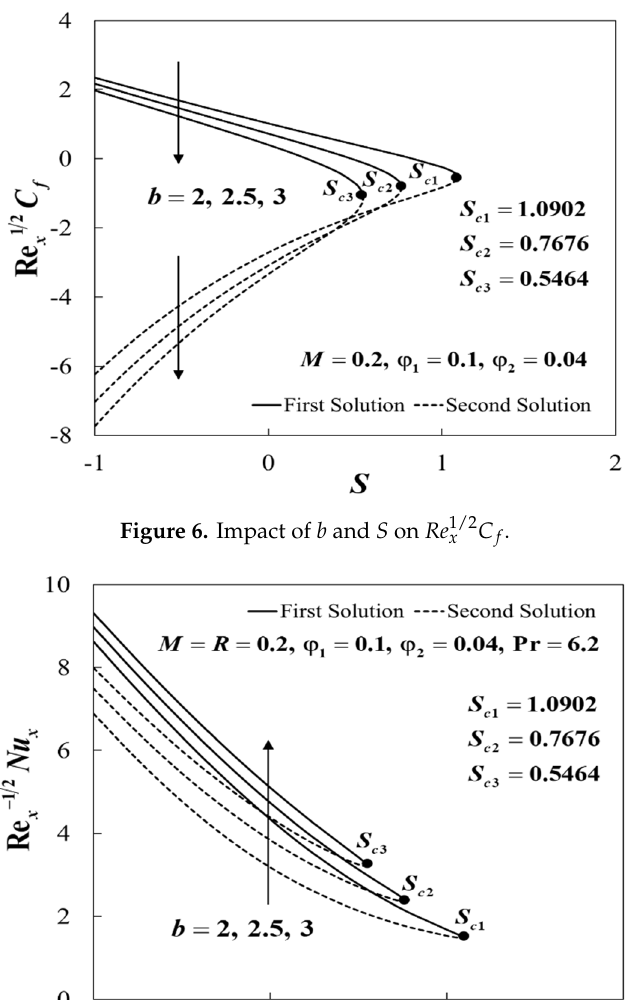
Figure 7. Impact of 𝑏 and 𝑆 on 𝑅𝑒 (cid:3051)(cid:2879)(cid:2869)/(cid:2870) 𝑁 𝑢 (cid:3051) .